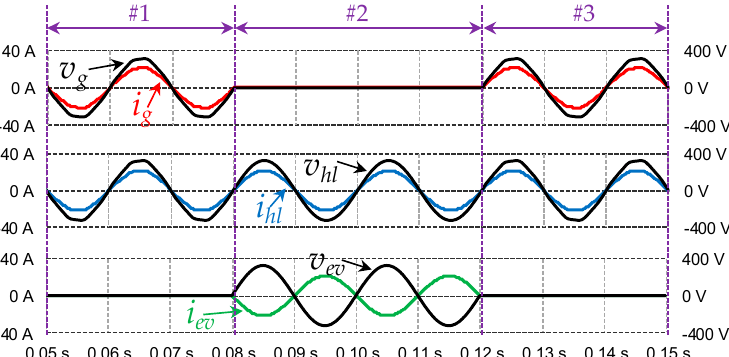
Figure 12. The principle of operation representative of the V2H mode (as an off-line uninterruptible power supply).